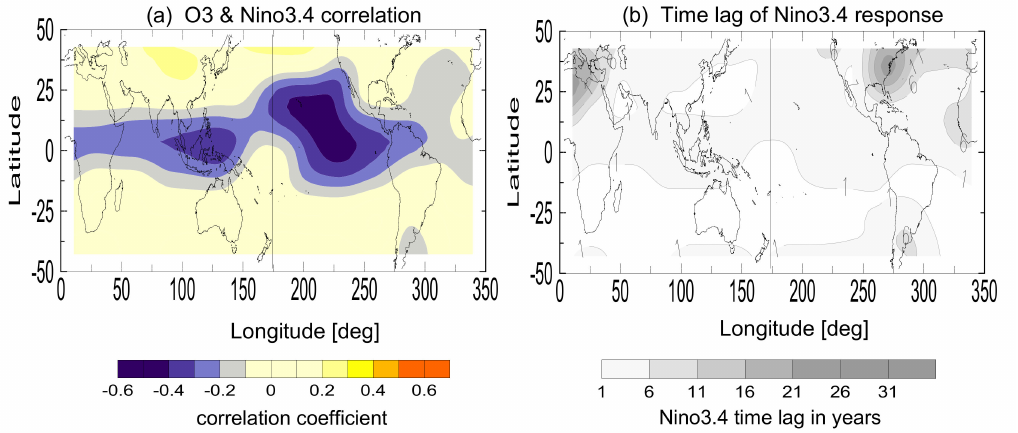
Figure 1. ( a ) Cross-correlation maps of the lower stratospheric ozone (the leading factor) and Nino3.4 index calculated from the winter values (December–April), over the period 1900–2010 (colored shading). ( b ) Time delay of Nino3.4 response to the chances of ozone density at 70 hPa (adapted from Velichkova and Kilifarska [10], their Figure